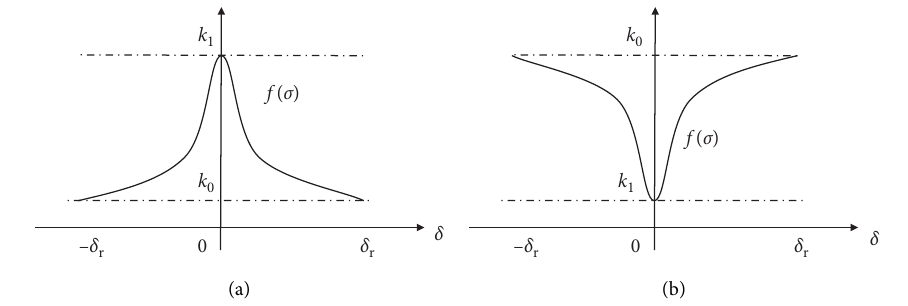
Figure 9: Gaussian function. (a) Downward. (b) Upward.